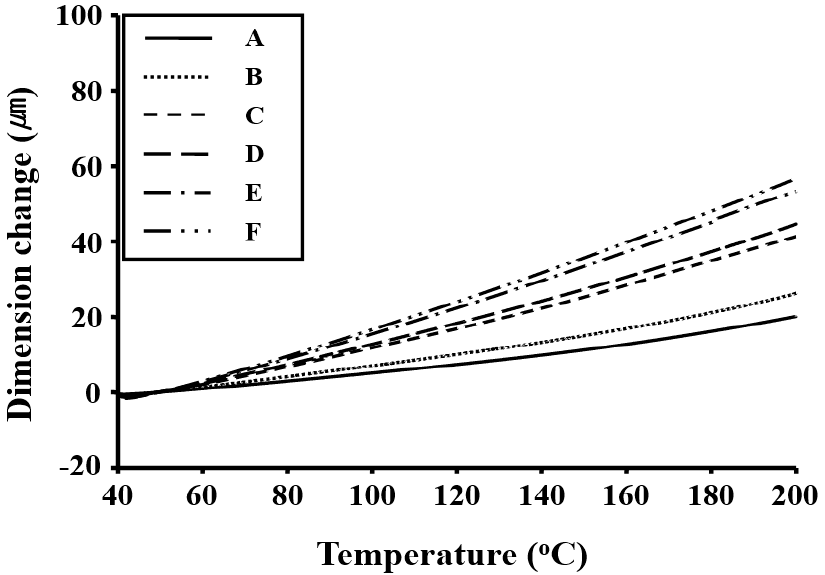
Figure 2. Thermomechanical analysis ( TMA) thermograms of the Co-PI films.